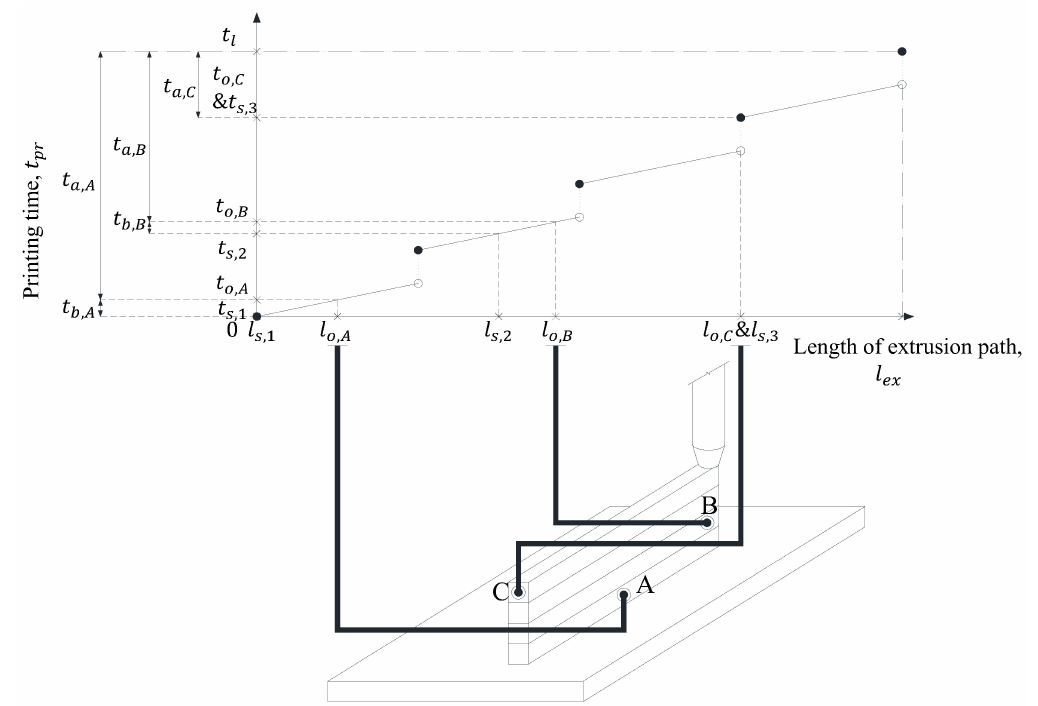
Figure 8. Calculation procedure of elapsed time according to element